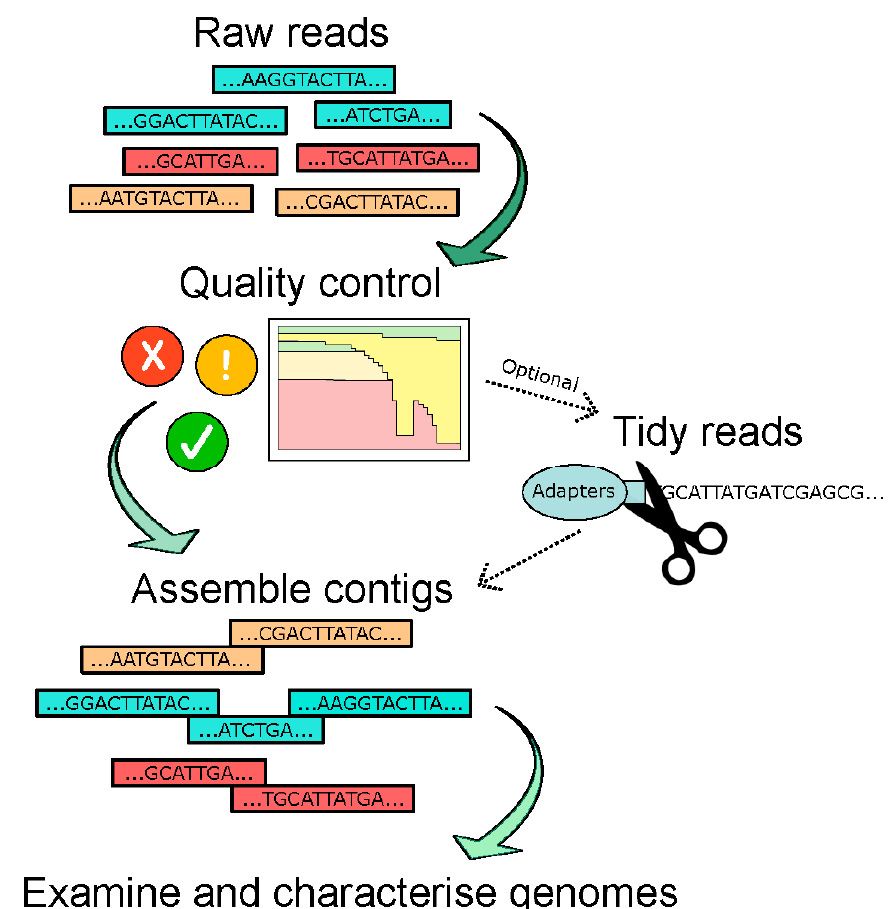
Figure 3. Overview of genome assembly as part of the bioinformatic pipeline used for virome/phageome analyses. Decontamination of samples to remove bacterial and other non-viral sequences can be done by positive or negative selection, i.e., filtration and selection of viral contigs from the total sample or the identification and removal of non-viral sequences, respectively. The compositional profile of the viral sample is often assessed by aligning the assembled reads to a reference database of known viruses using Basic Local Alignment Search Tool (BLAST) or other BLAST-based programs. Alternative sequence analysis methods such as k -mer algorithms, such as VirFinder and Libra, can reduce the time required for these analyses [80,81]. It is important to note that these programs can be extremely computationally heavy to work at such speeds. This k-mer based method is rare but has been used in some virome studies, including the gut virome study by Norman et al . [38]. These searches are restricted to reference databases like the NCBI Reference Sequence (RefSeq) database that are limited in the level of annotation they offer as they represent only a modest proportion of the total global virome [82]. Other references databases also exist such as Reference Viral Database (RVDB), which includes all viral sequences except for bacterial viruses [83], ViPR database [84], and GenBank, which is a collection of all annotated sequences [85].